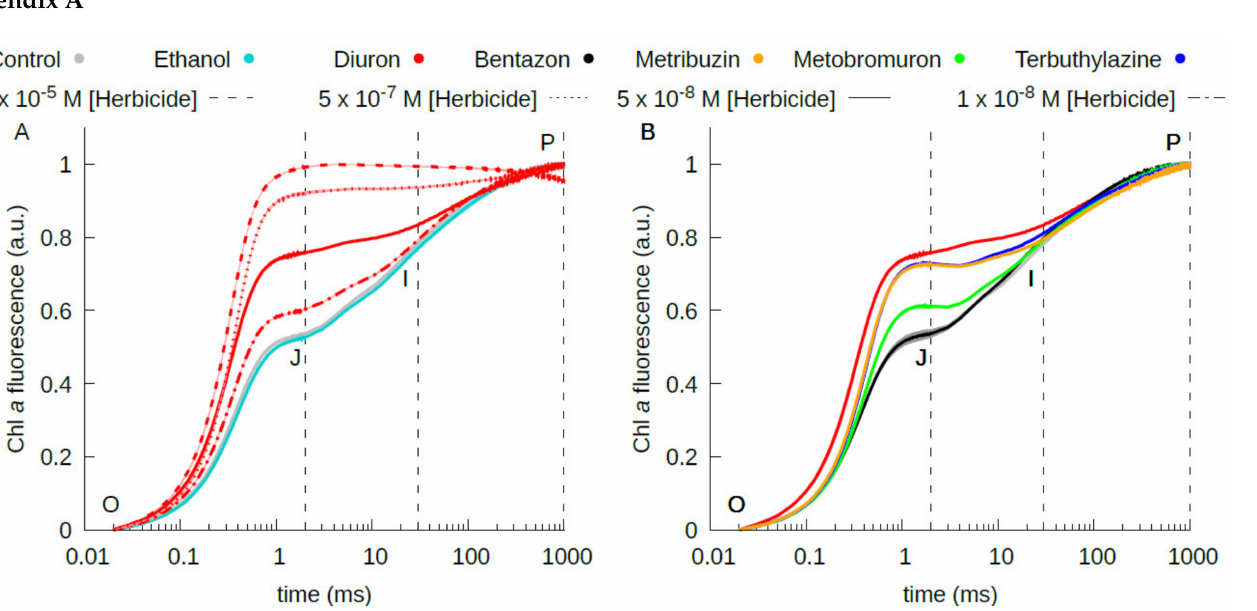
Figure A1. Chlorophyll a fluorescence induction (OJIP) transients (double normalized between O and P) of thylakoids treated with ethanol and four increasing concentrations diuron ( A ) and with 5 × 10 − 8 M diuron, bentazon, metribuzin, metobromuron and terbuthylazine ( B ) compared to untreated thylakoids (i.e., control). Lines are the mean of at least four measurements; the shade area covers the standard